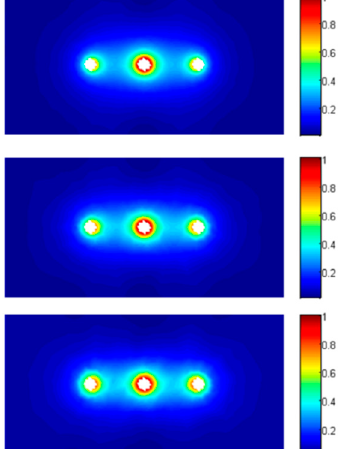
Figure 7. Electric field distribution @1 GHz in the XOY plane in the middle of the rods (from top to bottom: θ = 0.022 m 3 /m 3 , θ = 0.066 m 3 /m 3 and θ = 0.157 m 3 /m 3 ).